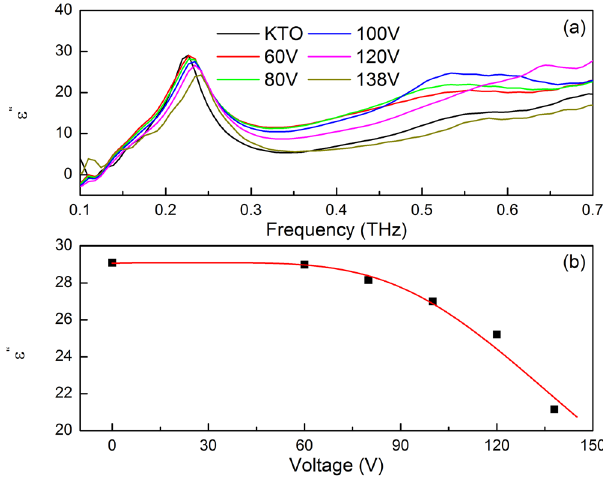
Figure 4. ( a ) Imaginary part of permittivity of KTO hybrid metamaterial sample and its variation under external voltages at room temperature. ( b ) Variation of ε ” at the